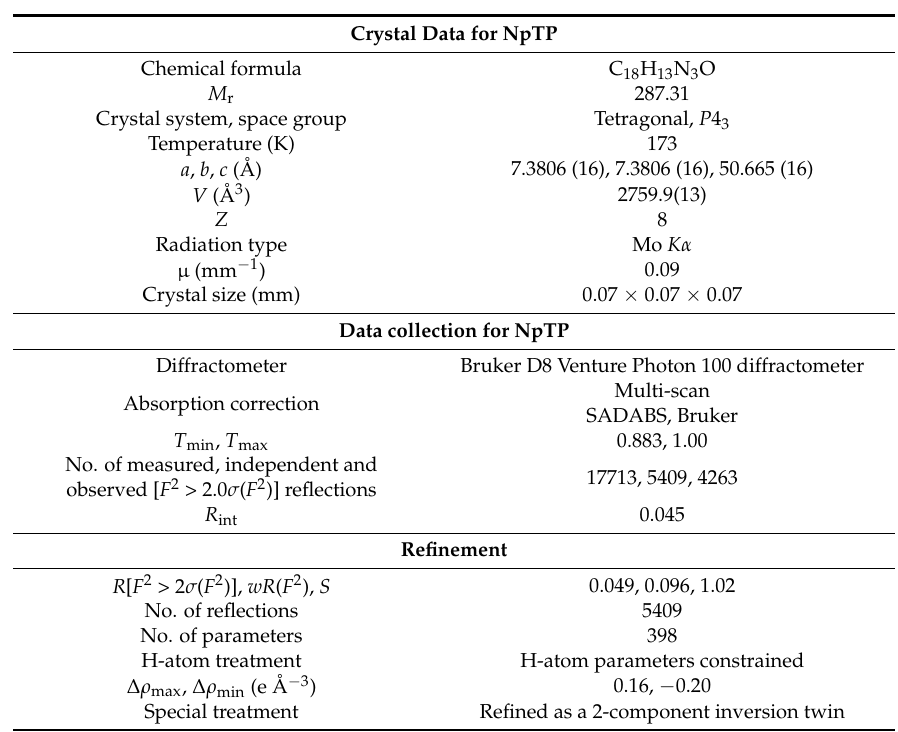
Figure 13. A view of the molecular structure of NpTP, showing the atom labeling. Displacement ellipsoids are drawn at the 50% probability level. Table 1. Experimental details for NpTP molecule for single X-ray crystal studies.